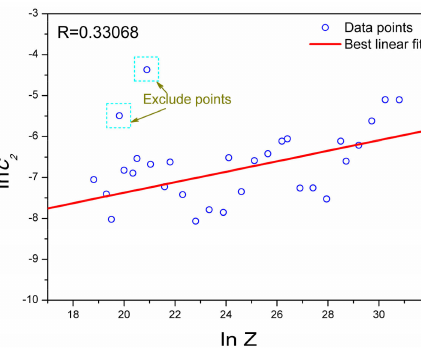
Figure 7. Relation between the material constant, c 2 , and the Zener-Hollomon